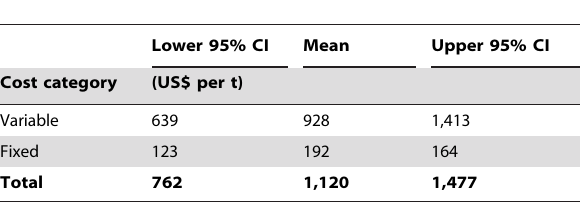
Table 5. Global cost (mean + / 2 95% CI) of fishing (Year 2005 US$ per t of catch), separated into variable and fixed cost component [18].